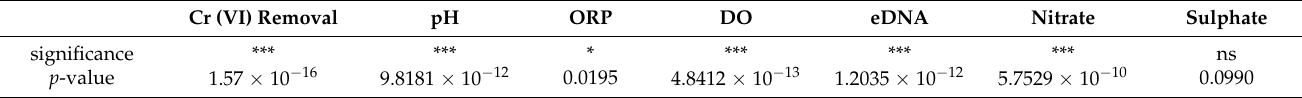
Table 6. p -values of the ANOVA for the microcosms’ monitored